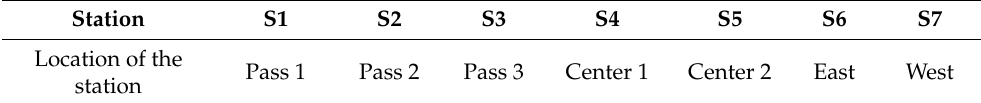
Table 1. Z. noltei field sampling stations in the Merja Zerga